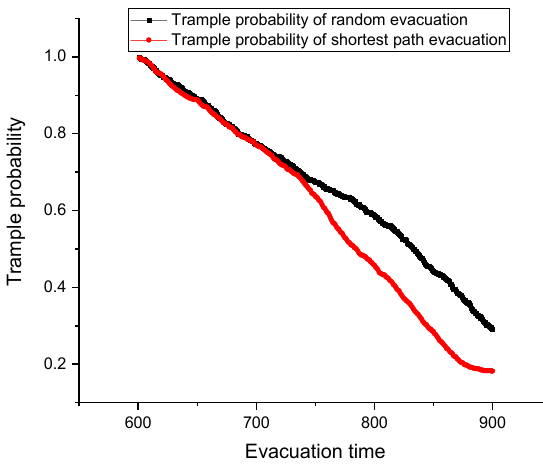
Figure 5. Pedestrian trample probability changes under two evacuation methods.